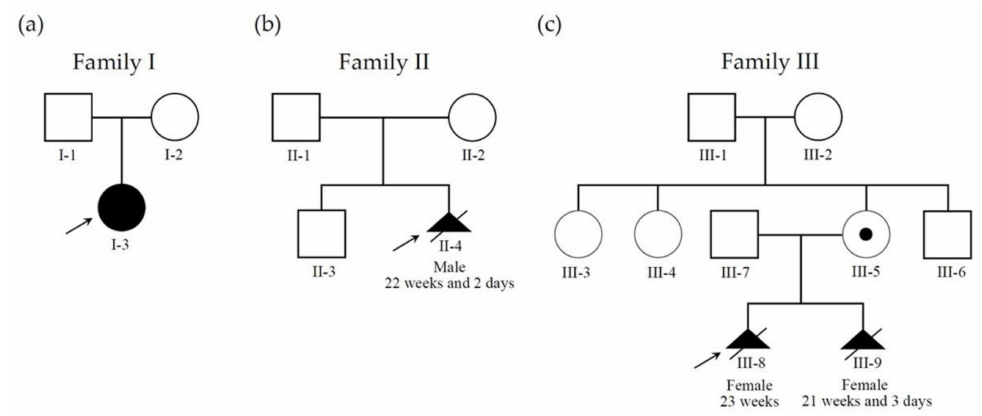
Figure 2. Pedigree information of three families with BWS cases. ( a ) Family I has a sporadic BWS child (case I-3; Patient 1) who was diagnosed as hypomethylation at maternal ICR2 on chromosome 11p15.5 region. ( b ) Family II has a sporadic BWS fetus (case II-4; Patient 2) who was diagnosed as hypomethylation at maternal ICR2. The parents accepted termination of pregnancy (TOP) at gestation age (GA) = 22 weeks and two days. ( c ) Family III has two consecutive BWS fetuses (case III-8 and III-9; III-9 is Patient 3). Both cases are diagnosed to have a maternal derived chromosome 11p15.5 deletion involving in ICR1 and H19 , resulting in hypermethylation in ICR1. The pregnant woman (III-5) carries a deletion on chromosome 11p15.5 in a mosaic status without phenotypic abnormalities. The parents opted TOP for both fetuses (case III-8 and case III-9) at GA = 23 weeks and 21 weeks and three days, respectively. Male indicated by square, female by circle, carrier by a dot in the middle of the symbol, affected individual by filled symbol, TOP by triangle with a slash, and proband by